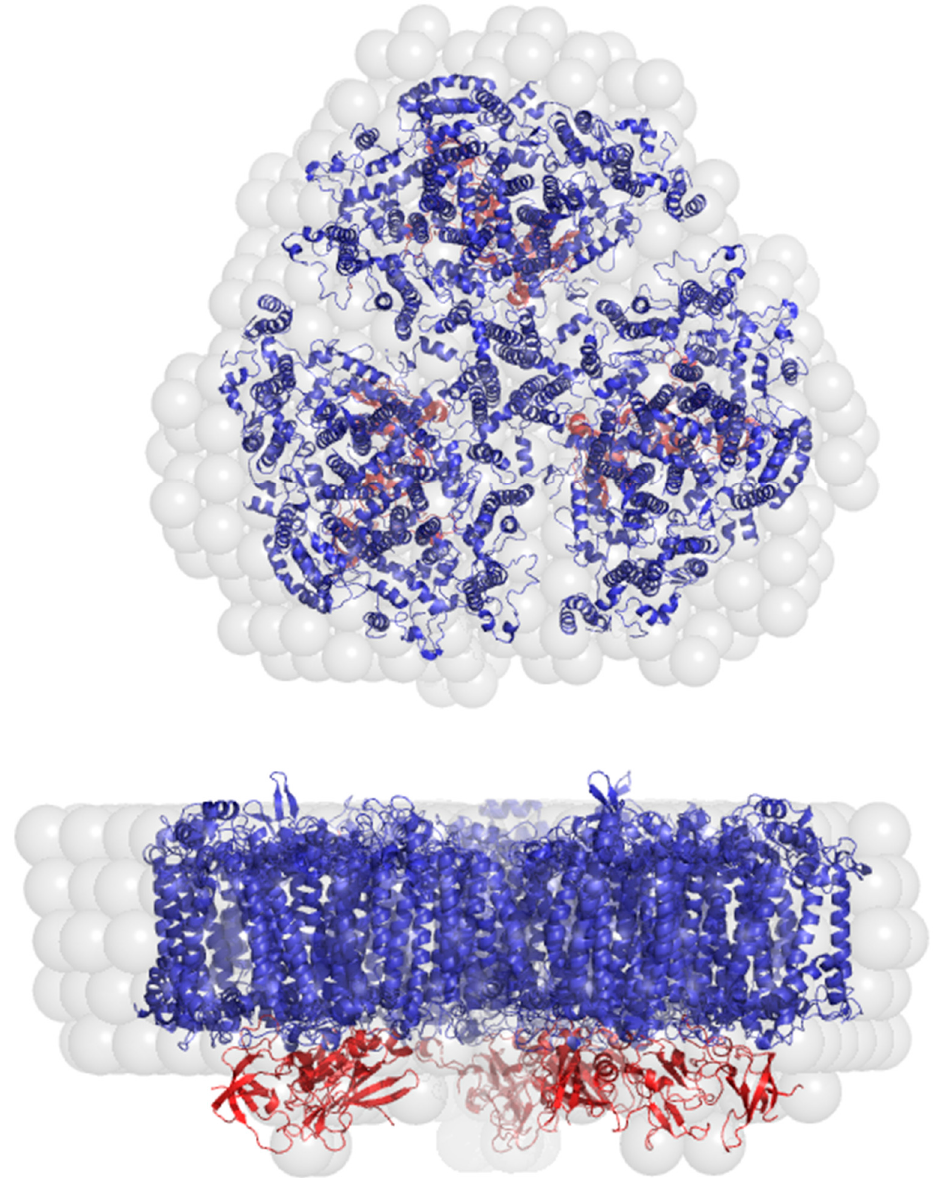
Figure 4. Top view ( upper panel ) and lateral view ( lower panel ) of the structure of PSI reconstituted based on the 5% D 2 O contrast matched SANS data shown in Figure 3 using the Dammif software tool (grey spheres). For the comparison, the membrane-intrinsic and membrane-extrinsic subunits of the PSI crystal structure are shown in blue and red, respectively (pdb code 1jb0